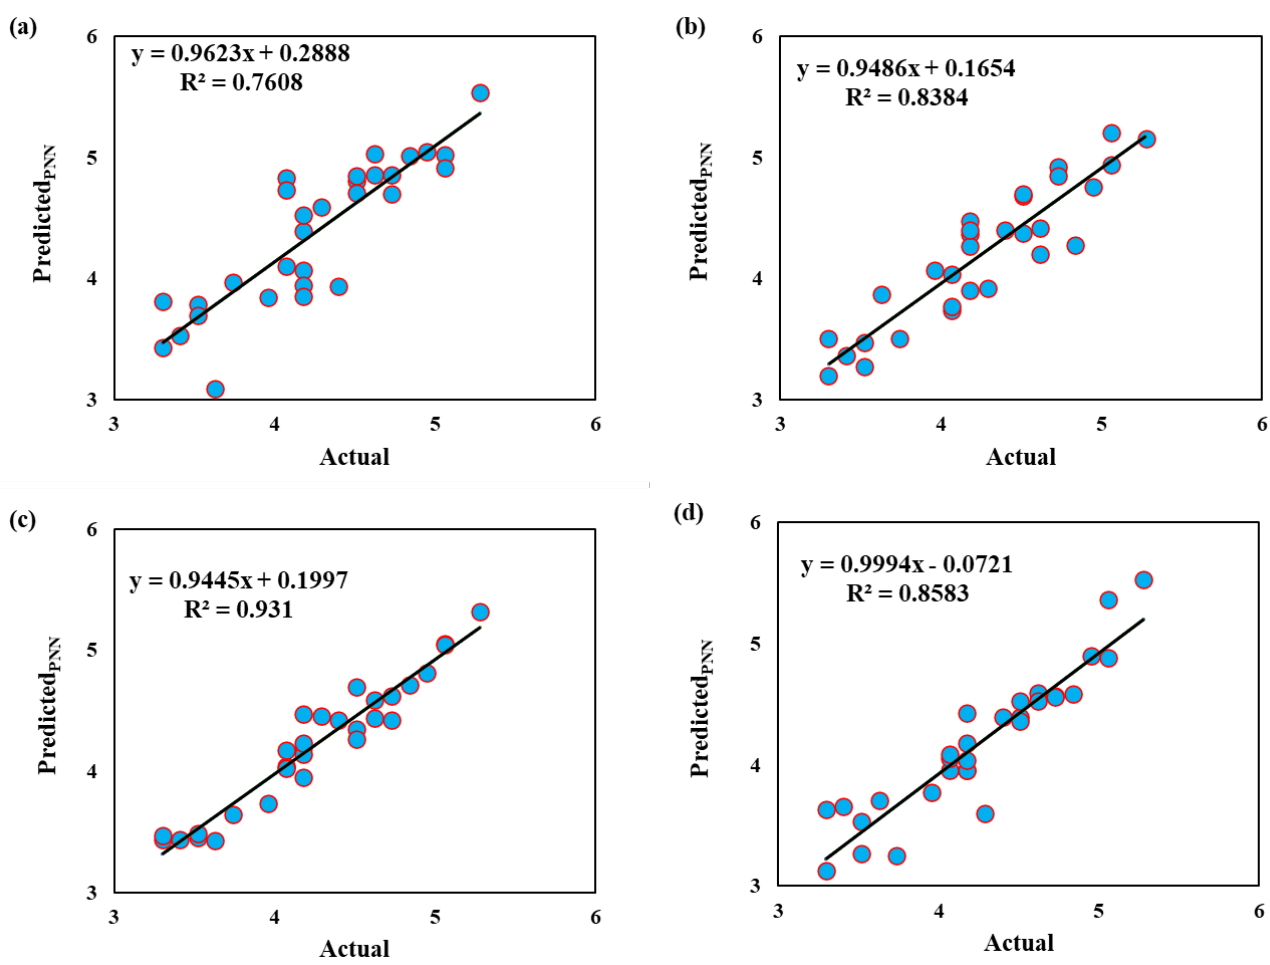
Figure 8. Scatter Plots for the PNN method: ( a ) Model-1; ( b ) Model-2; ( c ) Model-3; and ( d ) Model-4, respectively.